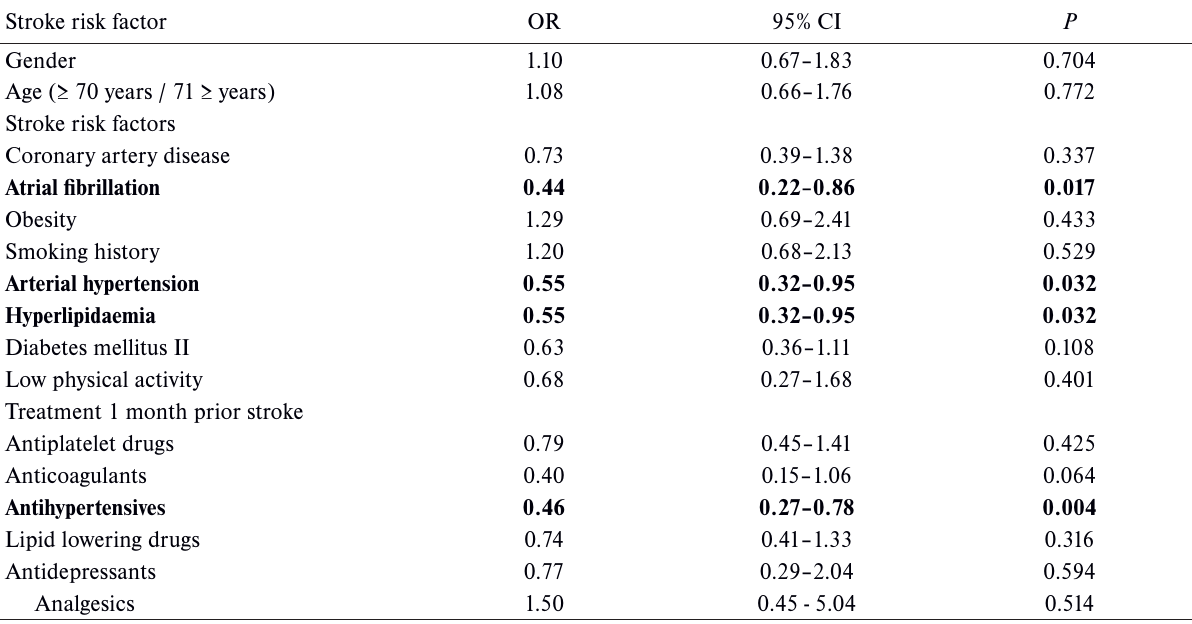
Table 2. Results of binary logistic regression analysis (unadjusted OR) - dependent variable presence of spasticity. Stroke risk factor